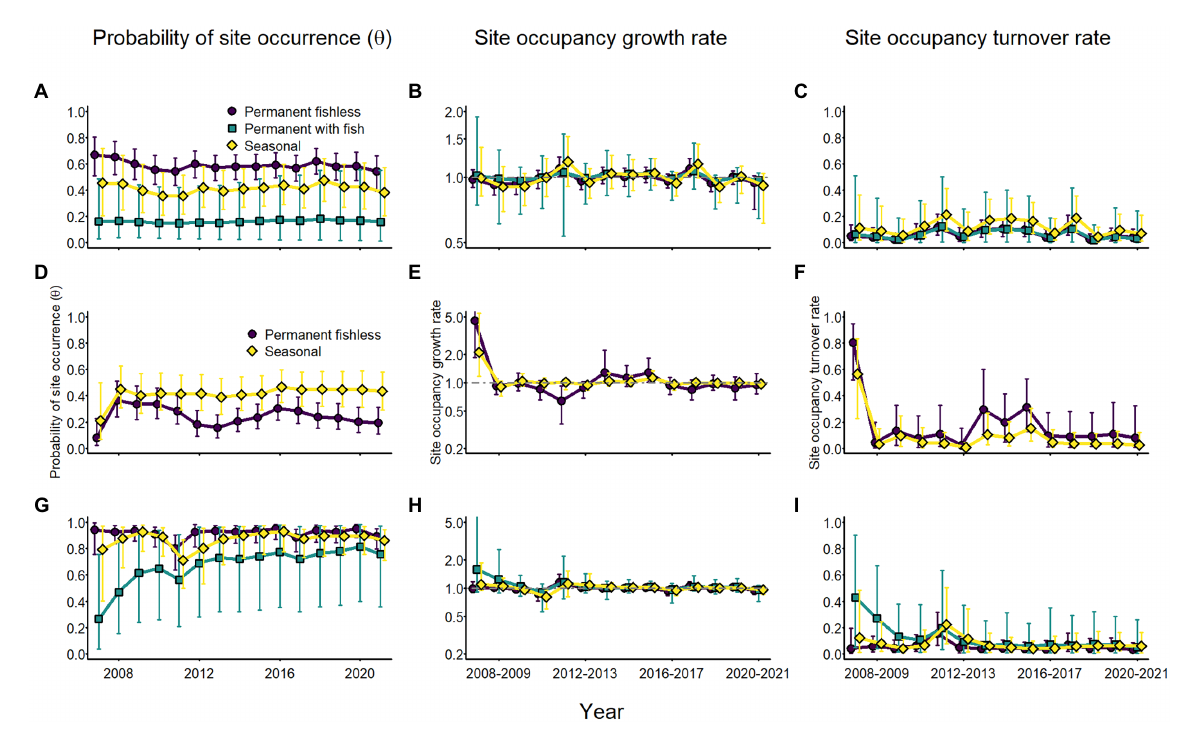
FIGURE 9 Annual estimates of site occupancy probability (A,D,G) , site occupancy growth rate (B,E,H) , and site occupancy turnover rate (C,F,I) for Sierra Nevada yellow-legged frogs [ Rana sierrae ; (A–C) ], Yosemite toads [ Anaxyrus canorus ; (D–F) ], and sierran treefrogs [ Pseudacris sierra ; (G–I) ] by site type (indigo circles and line = permanent [and fishless for panels (A–C) and (G–I) ]; aqua squares and line = permanent with fish; gold diamonds and line = seasonal) based on modeled relationships with climate variables and random annual variation in colonization and extirpation probabilities in Yosemite National Park, California, United States, 2007–2021. Points represent posterior medians; error bars represent 95% equal-tailed intervals. The gray horizontal dot-dash line at 1.0 in panels (B,E,H) indicates stable